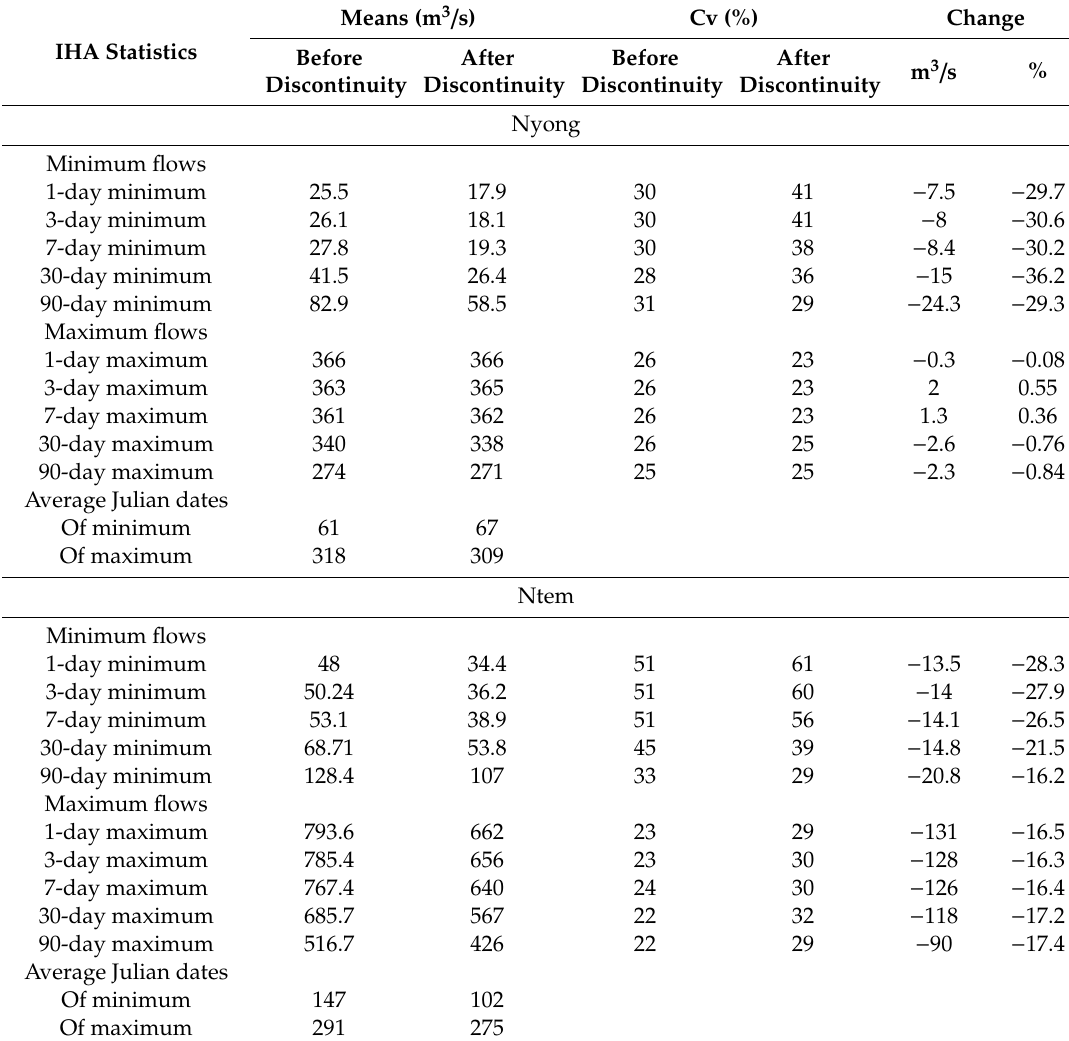
Table 4. Statistics relating to the maximum and minimum flows of Nyong and Ntem before and after the discontinuity. IHA: Indicators of Hydrologic